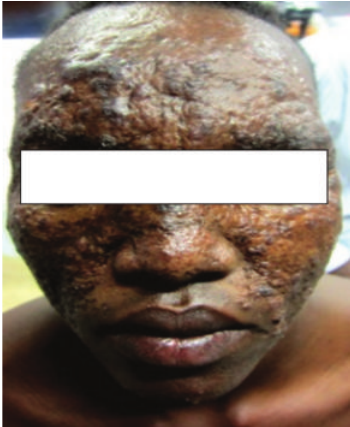
Figure 1: Of patient no. 1 showing papules, nodules, and plaques in the face.